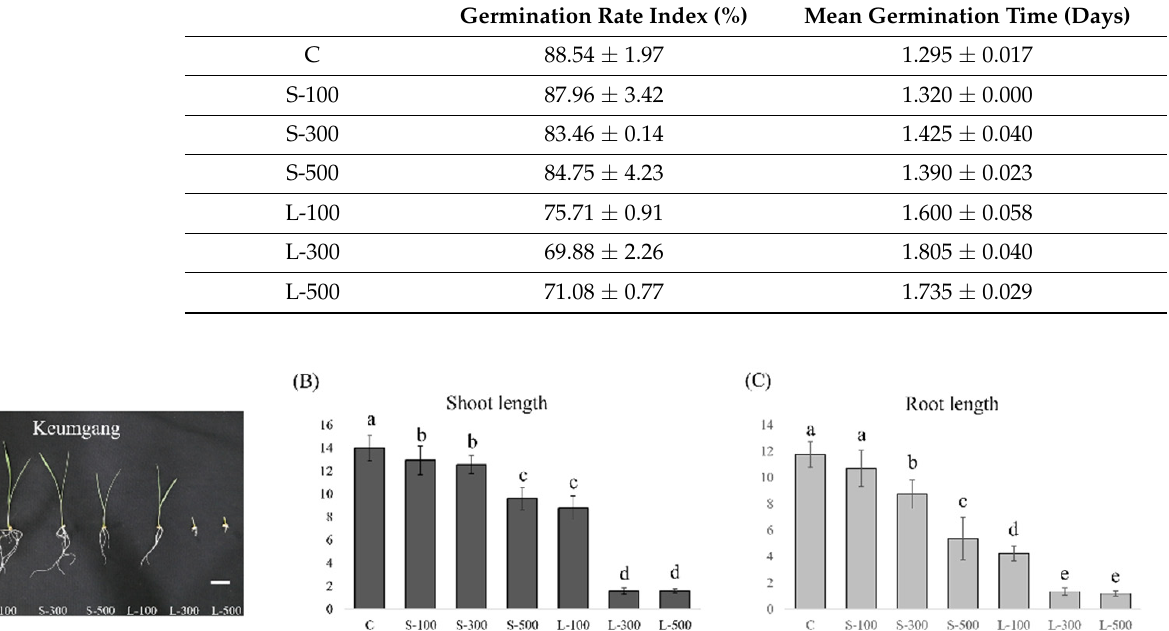
Figure 3. Gamma irradiation effect on plant growth under different doses and exposure times. ( A ) Image of plant growth under different irradiation conditions. Scale bar: 2 cm. ( B ) Shoot and ( C ) root length 10 days after germination. Each bar represents the mean ± SD ( n = 10). Values with different letters are significantly different using Duncan’s multiple range test ( p < 0.05).